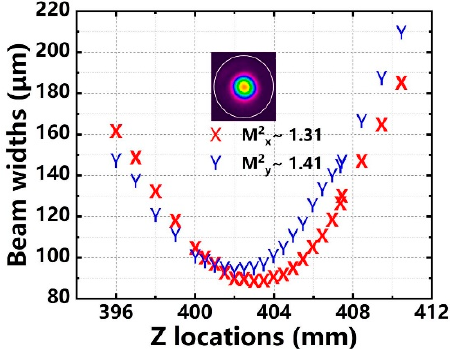
Figure 7. Beam quality at 3.96 kW.